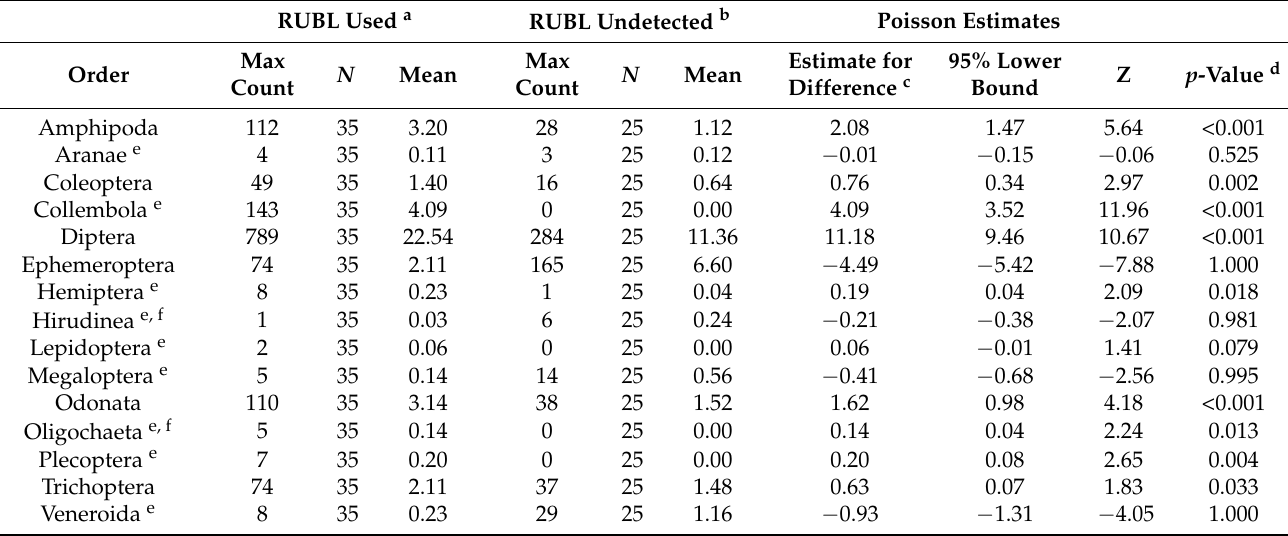
Table 4. Summary statistics and results of a 2-sample Poisson rate test for differences between maximum invertebrate specimen abundance per survey per order from three aquatic macroinvertebrate surveys per site for sites with and without Rusty Blackbird (RUBL) detections in northern New England in